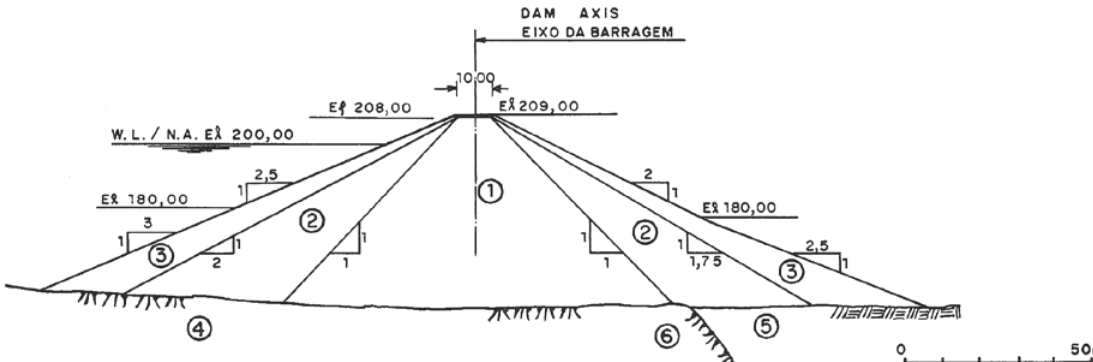
Figure 2 - Dam Orós (Araújo